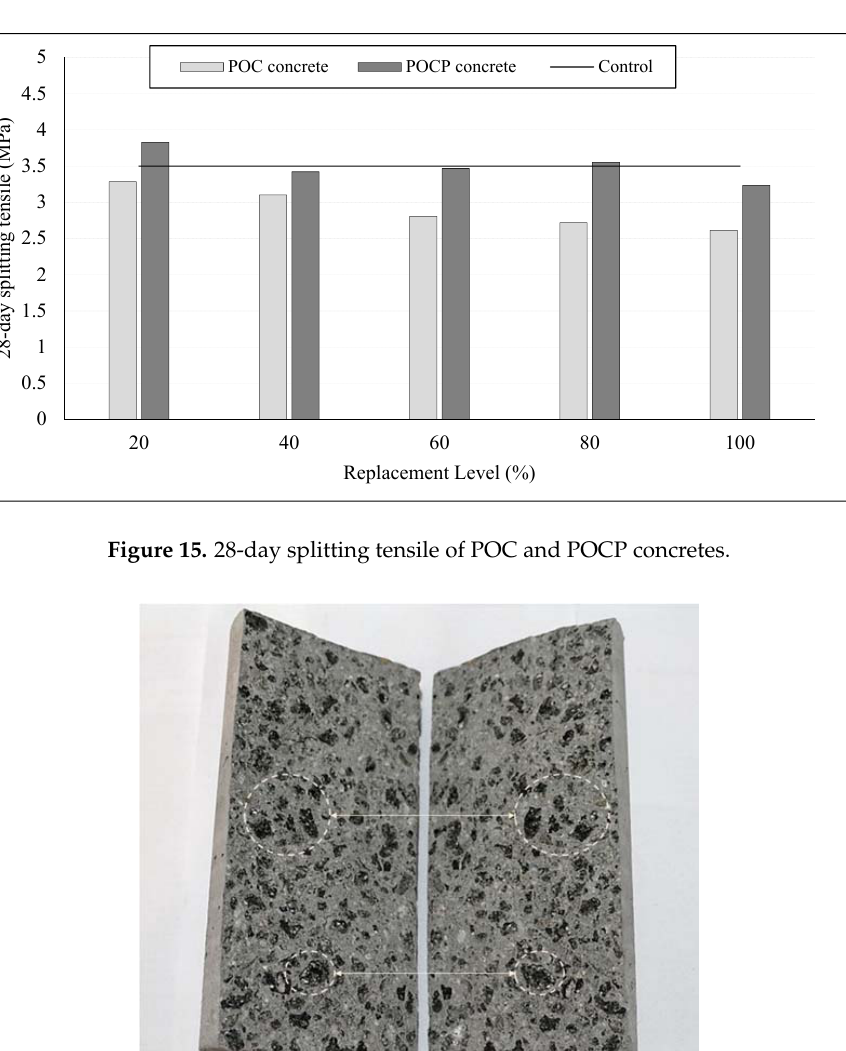
Figure 14. Relative compressive strength of POCP concrete.